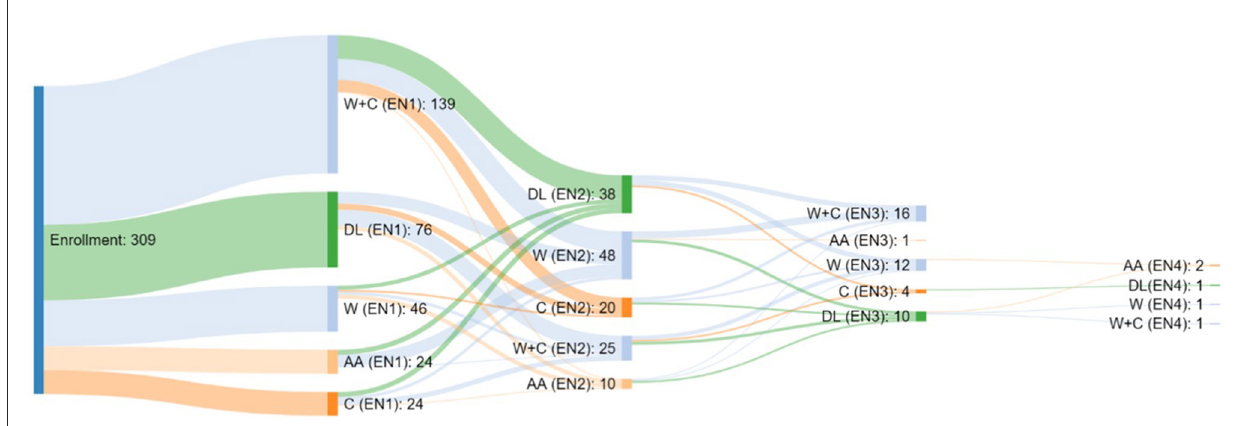
FIGURE2 Type of Enteral Nutrition taken by the patients enrolled in the study and relative switch.